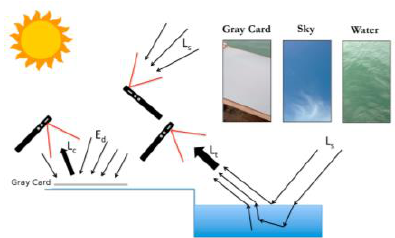
Figure 6: The application layout and and example of Secchi disk usage (Source: University of Plymoth Enterprise